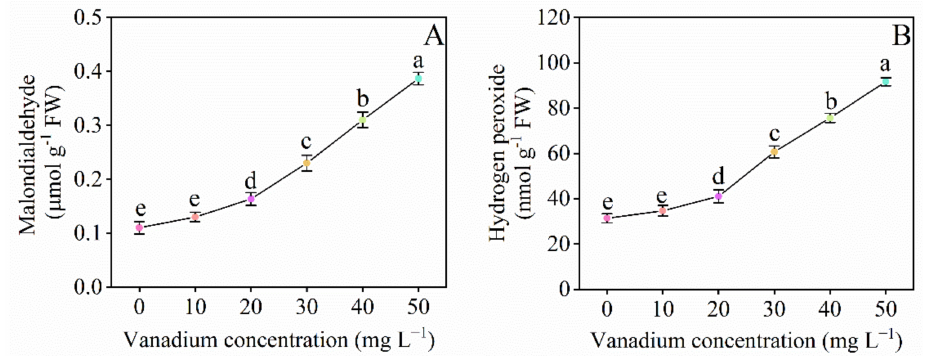
Figure 8. Effect of vanadium on Malonaldehyde ( A ) and hydrogen peroxide ( B ) content in pepper seedlings. Means ± SE, n = 4, significant differences are exhibited by lowercase letters (at p < 0.05), according to Fisher’s least significant difference